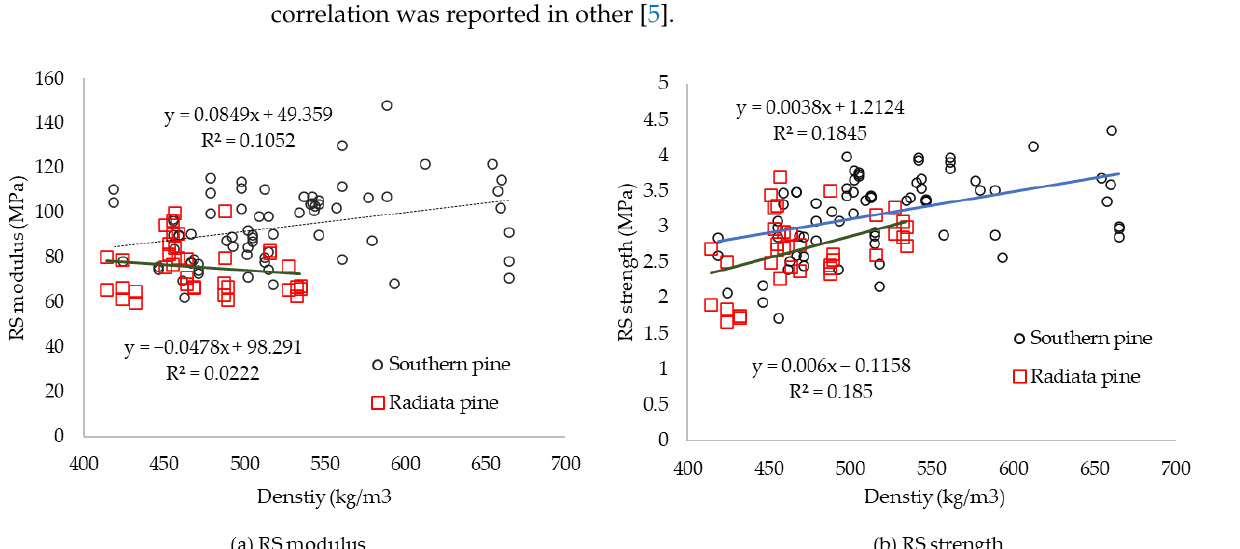
Figure 14. Linear regression between density and rolling shear